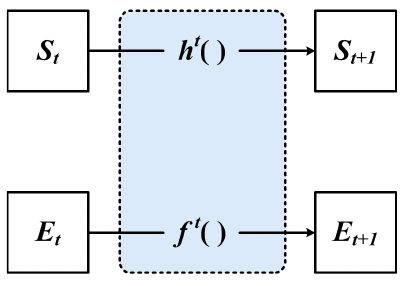
Figure 5. The classical